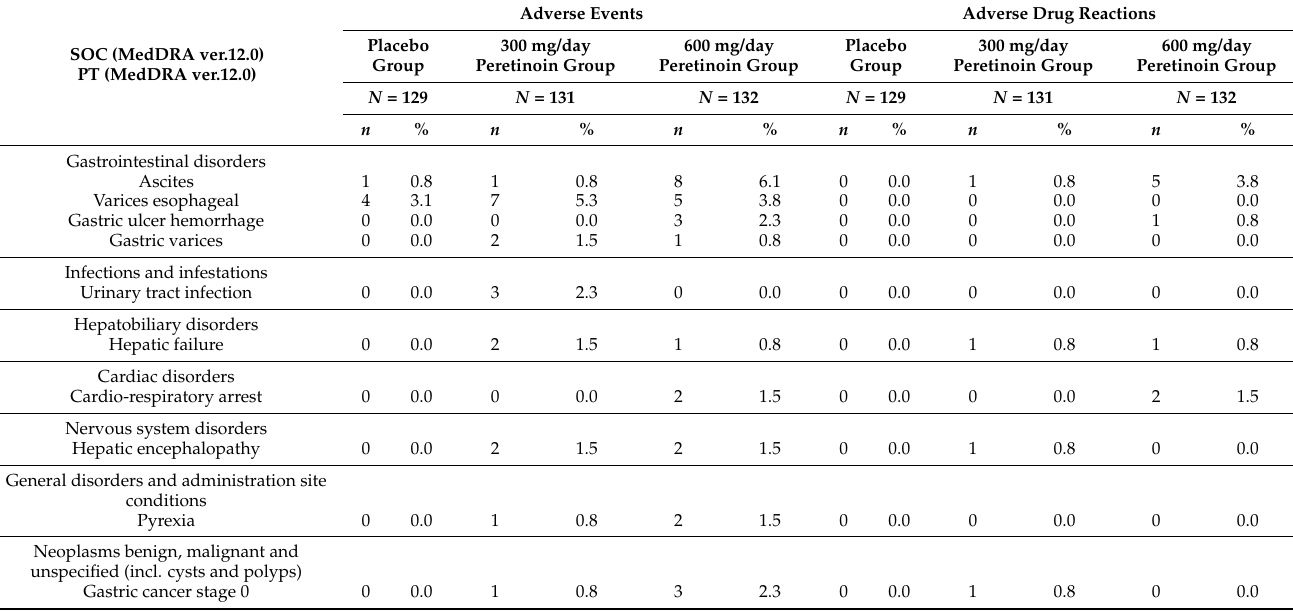
Table 3. Serious adverse events of incidence ≥ 1% higher in either peretinoin group than in the placebo group, and rates of hepatic neoplasm malignant